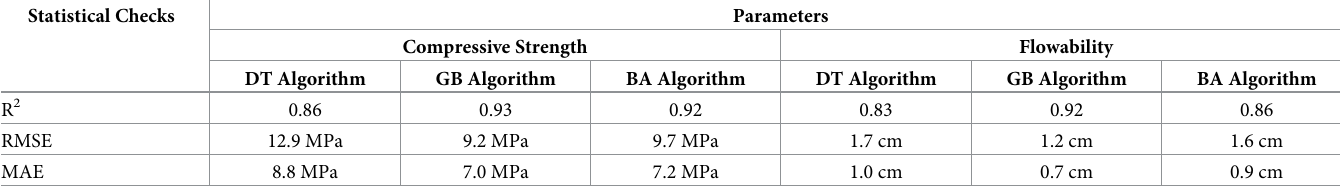
Table 1. Statistical evaluation for DT, GB and BA